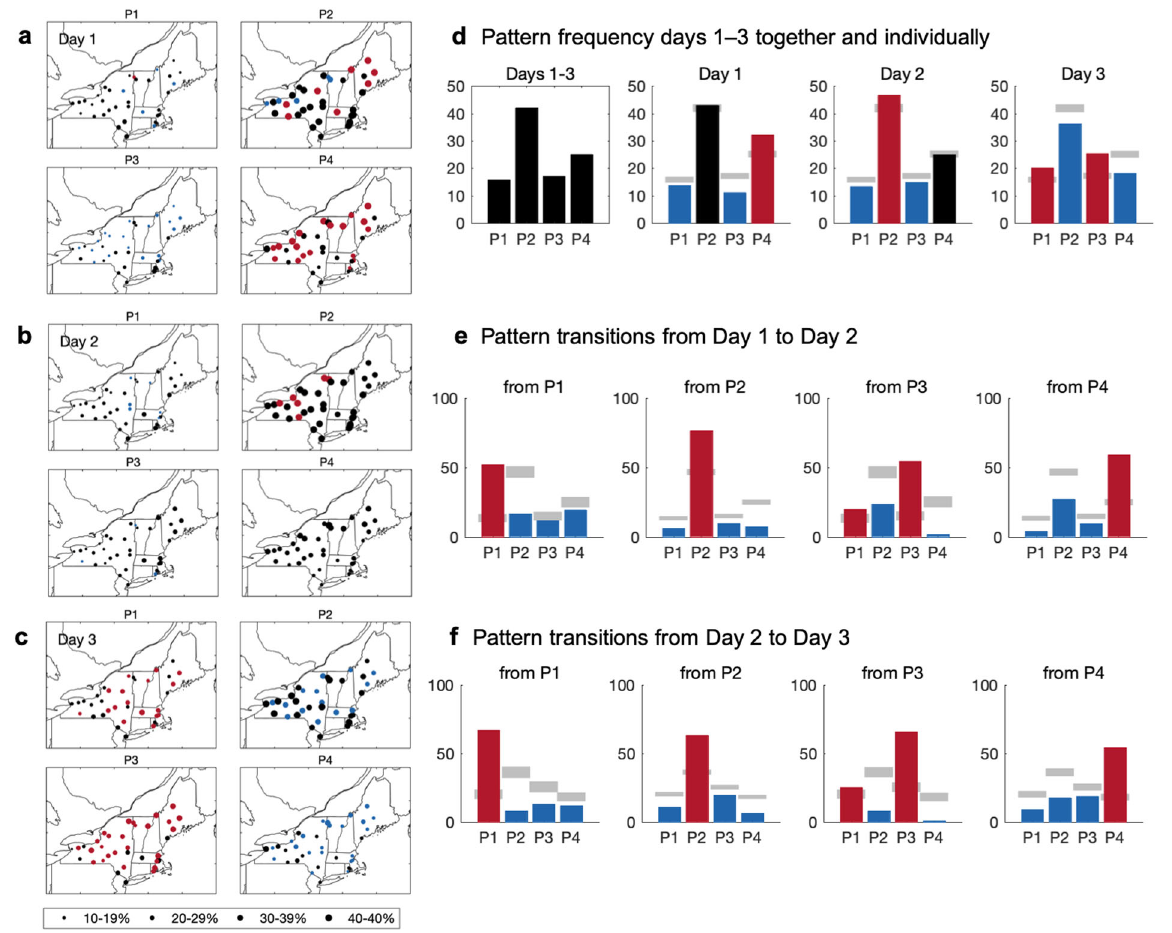
Fig. 3 Pattern transitions for fi rst three days of station heat wave events. Percent (dots, where dot size is proportional to frequency) of station heat wave events that occur in pattern P1 – P4, and where red, blue, and black dots indicate, respectively, higher-than-normal, lower- than-normal, and normal values at the 0.05 level of signi fi cance, for a day 1 b day 2 and c day 3 of station heat wave events. d Percent of pattern assignments P1 – P4 for (left to right) combined and separate days 1 – 3 of station heat wave events. e Frequency of transitions from P1 – P4 on day 1 to next-day P1 – P4 for station heat wave events. f Frequency of transitions from P1 – P4 on day 2 to next-day P1 – P4 for station heat wave events. For d – f , all station heat wave days 1 – 3 are counted, regardless of whether other stations share the same heat wave day. Red, blue, and black bars indicate, respectively, higher-than-normal, lower-than-normal, and normal values at the 0.05 level of signi fi cance, and gray shading indicates the 95% con fi dence interval of background frequency based on random